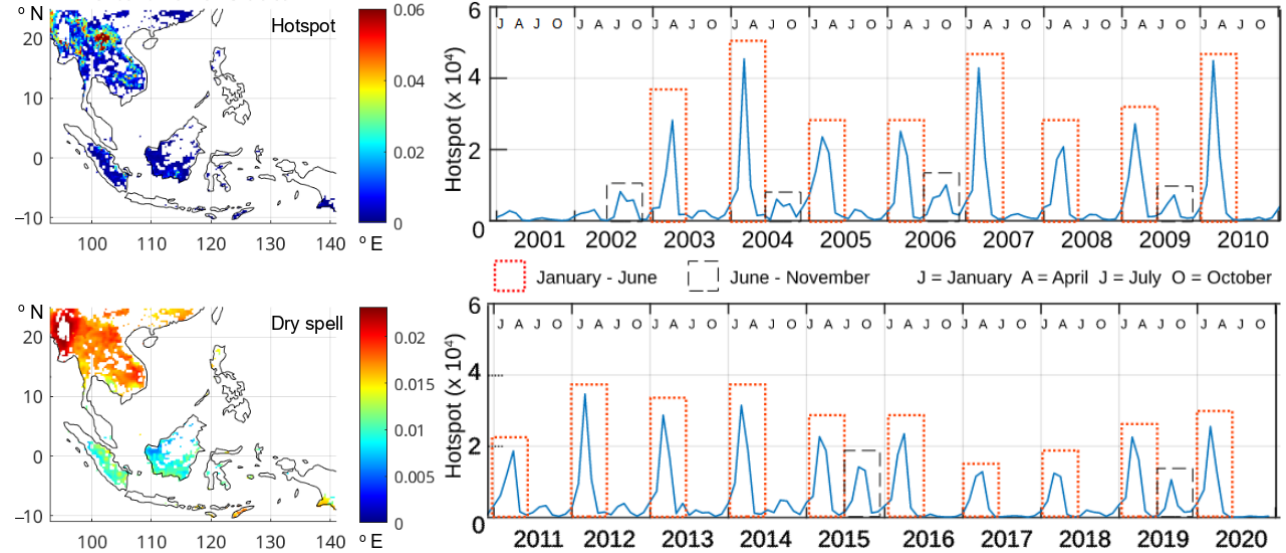
Figure 1. Southeast Asia analysis—first spatial pattern of the hotspot ( top ) and dry spell ( bottom ), as well as temporal pattern of a hotspot, 83.8% of SCF value.